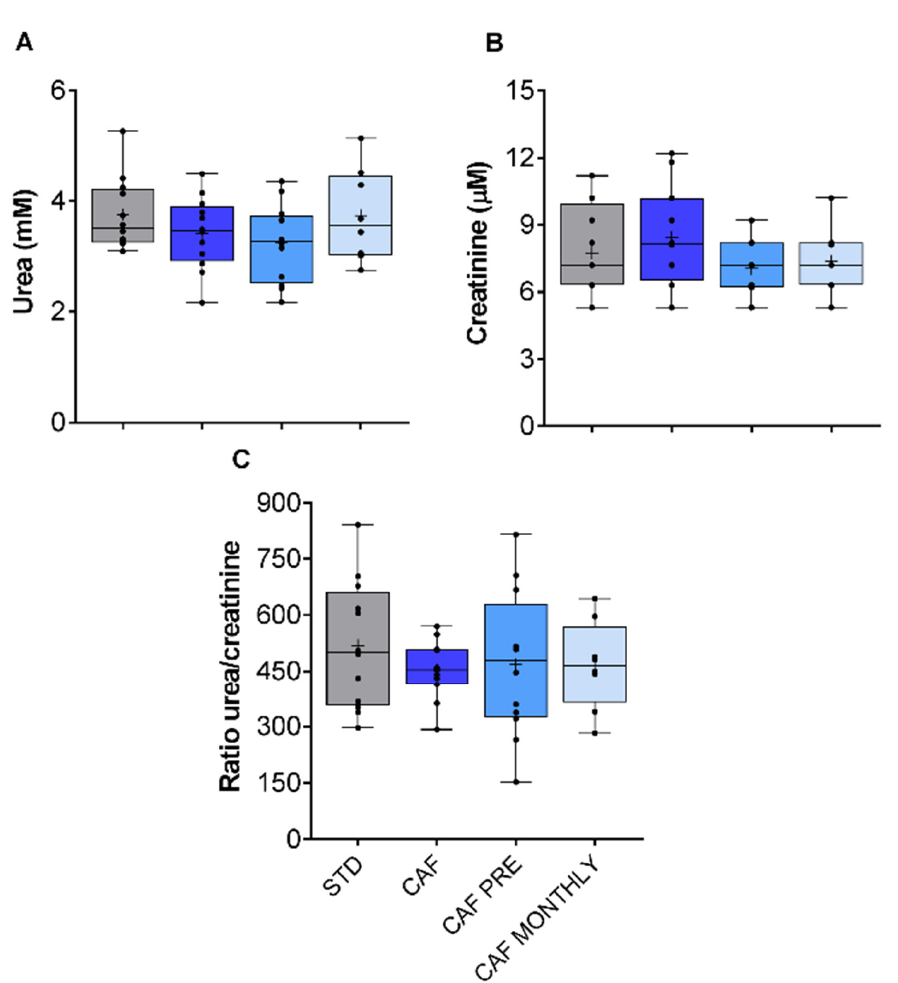
Figure 5. Renal metabolism-related biochemical parameters. ( A ) Urea levels. ( B ) Creatinine levels. ( C ) Urea/creatinine ratio. STD: lean rats fed a standard diet; CAF: rats fed a cafeteria diet; CAF PRE: rats receiving preventive treatment of GSPE during 10 days before cafeteria diet intervention; CAF MONTHLY: rats receiving GSPE treatment during 5 days once per month simultaneously fed with cafeteria diet. Values are represented as boxplots showing the median and the IQR. Means are represented as +.